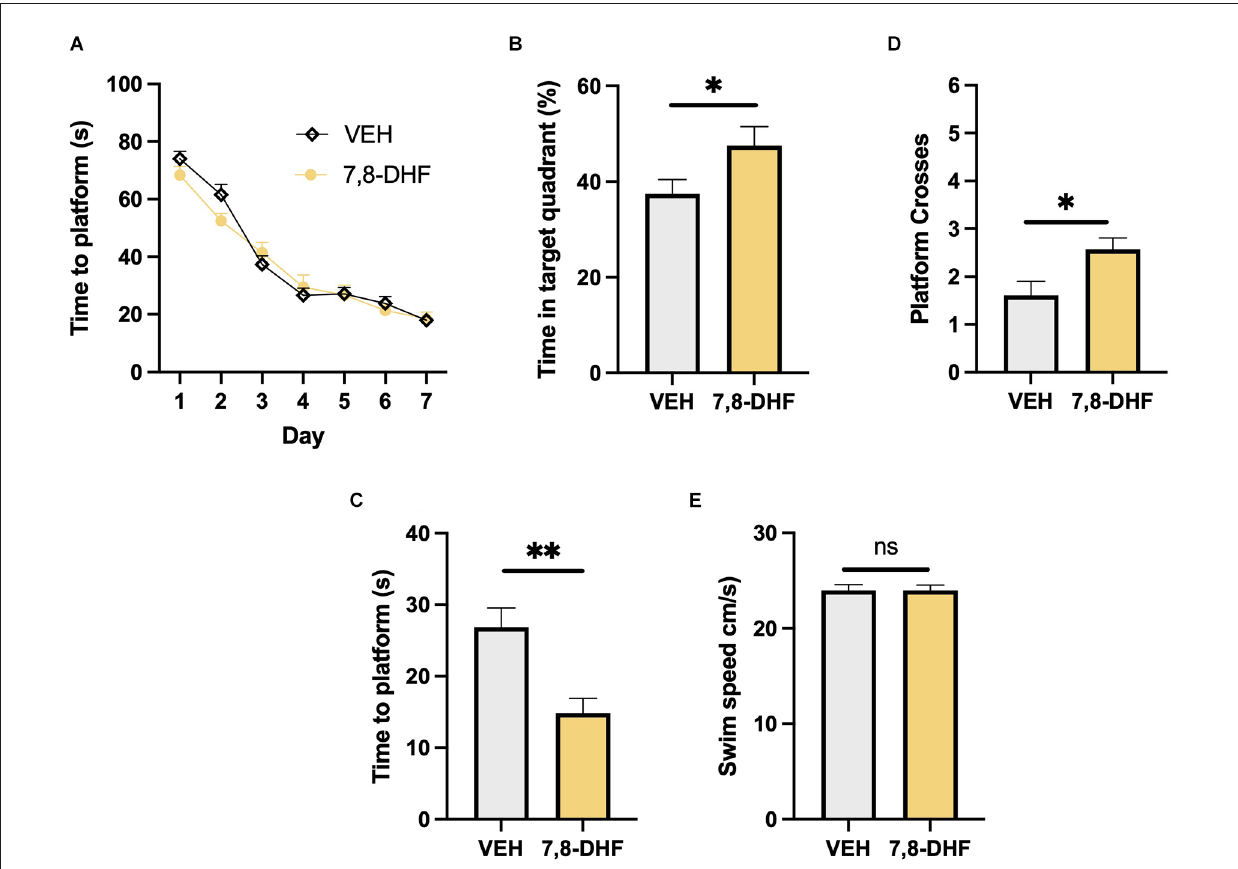
FIGURE1 Long-term memory performance in the Morris water maze. (A) Both the mice that received 7,8-DHF and vehicle following each training session successfully learnt the location of the platform during the training period. (B) The 7,8-DHF group spent a greater percentage of time in the target quadrant during the 28-day probe test. (C,D) The 7,8-DHF group found the platform quicker and crossed it more often than the controls. (E) Swim speed was equivalent between groups . Data presented mean ± SEM. ∗ < 0.05, ∗∗ < 0.01, ns: not significant.